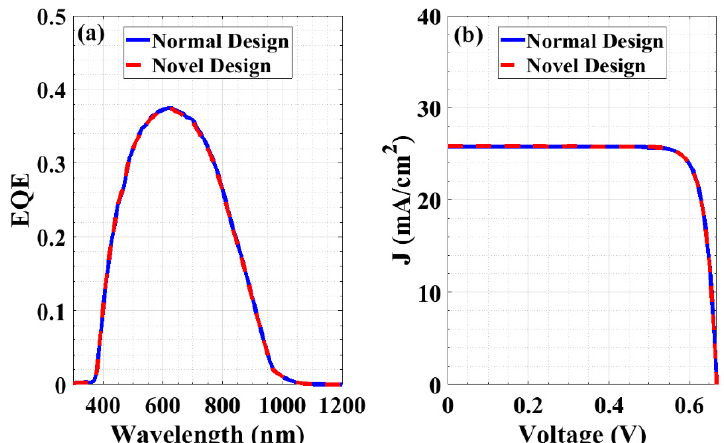
Figure 3. Optoelectronic characteristics of both the novel and normal designs under illumination ( a ) EQE and ( b ) J-V characteristics.